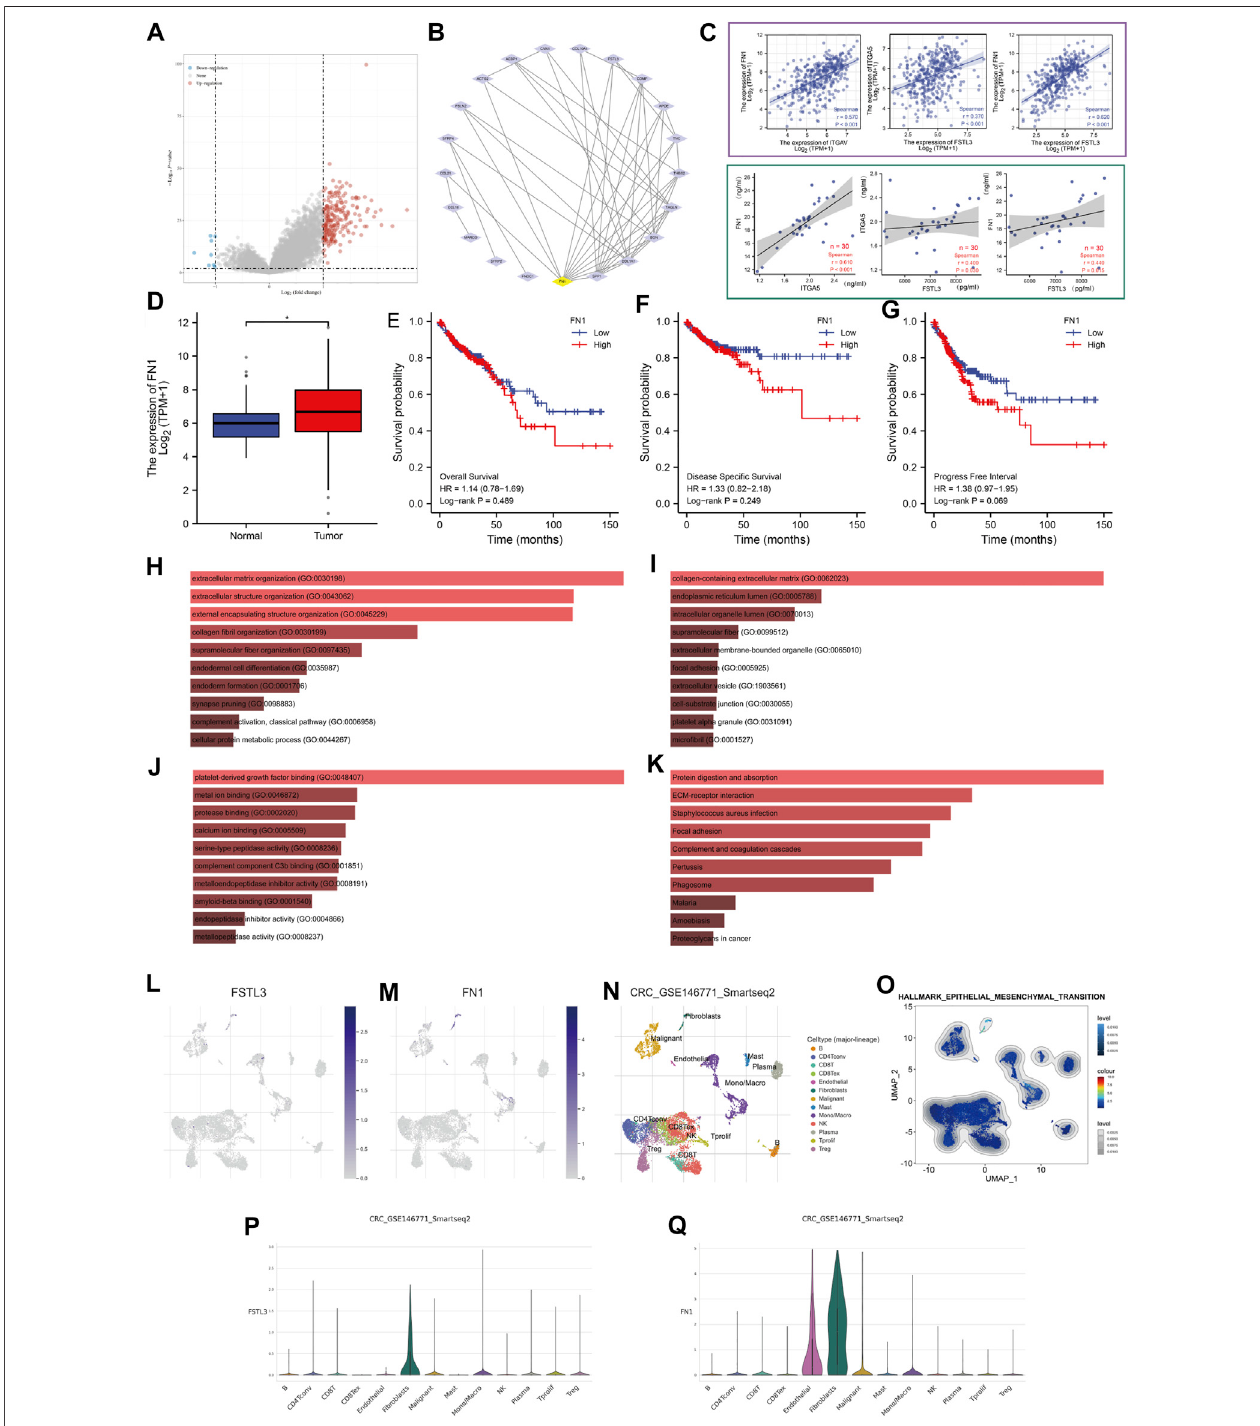
FIGURE 3 | Protein-protein interaction (PPI) network and enrichment analysis. (A) Volcano map of the genes showing differential expression after a change in the FSTL3 levels. Red dots, upregulated genes; blue dots, downregulated genes; abscissa, differences in the gene expression (log2 fold change); and ordinate, the signi fi cance of these differences ( − log10 padj). (B) The protein-protein interaction (PPI) network of FSTL3 and its related genes. (C) TCGA-based correlation analysis between FN1,ITGA5, and FSTL3 (areawithinthegreenbox).AnalysisofthecorrelationbetweentheserumFN1,ITGA5,andserumFSTL3inthepatientsbasedon thecomparisonbetweenthetwogroups(areawithinthepurplebox). (D) Expressionof FN1 inthenormalandtumortissuesbasedonTCGA-COADdata. (E – G) TheOS, DSS, and PFI from The Cancer Genome Atlas-COAD database are based on the FN1 expression levels. (H – K) Functional enrichment analysis of the FSTL3 -related